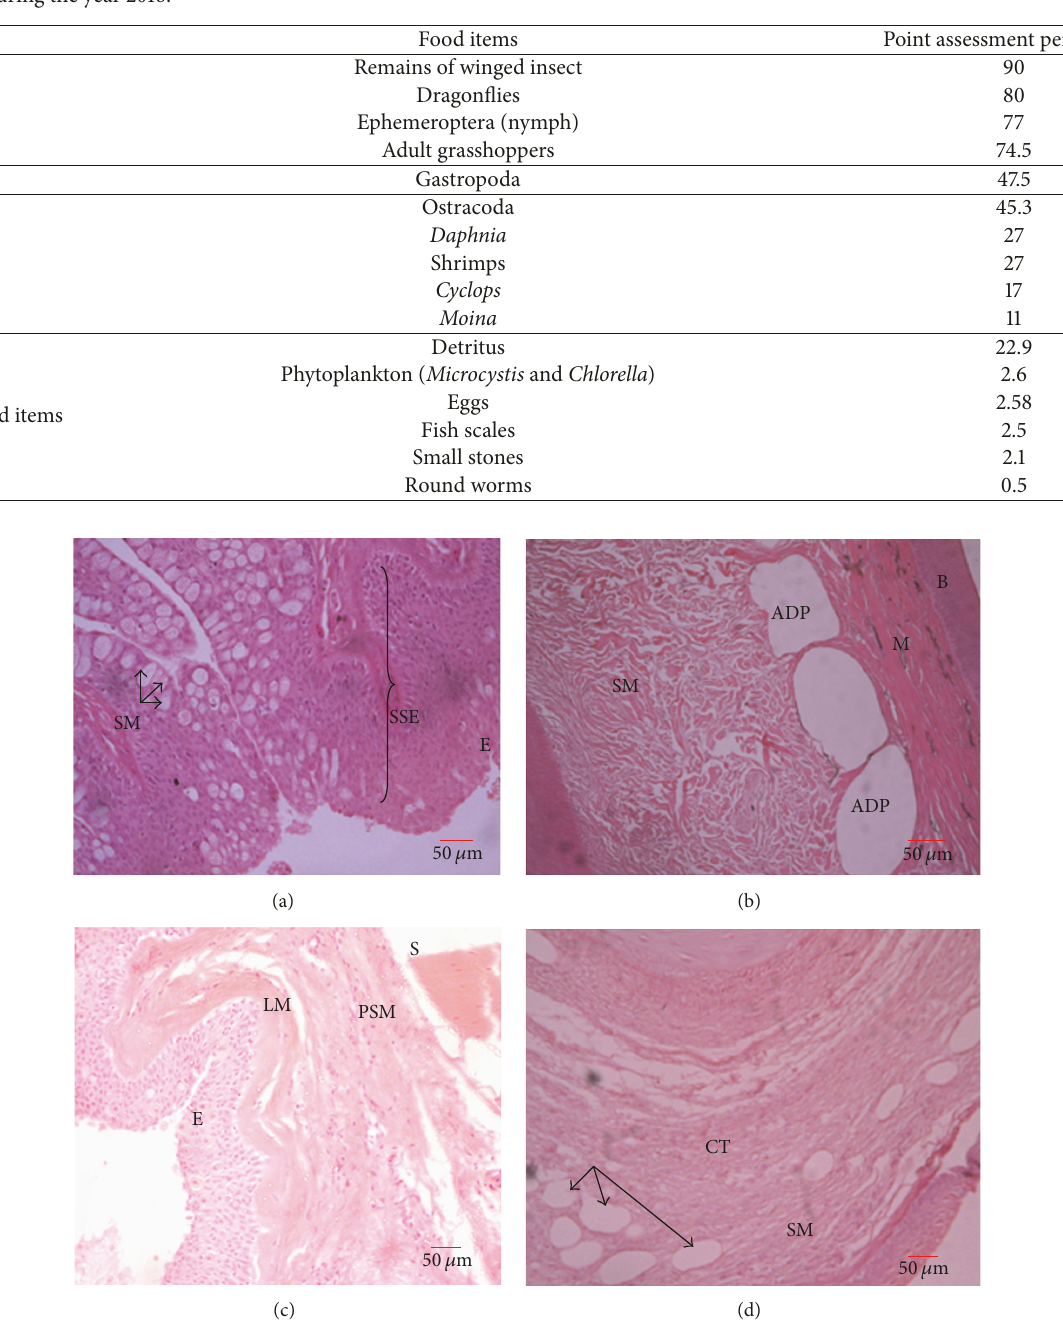
Table 2: Point assessment percentages of various categories of food items in the stomachs of Alestes baremoze collected from Lake Albert, Uganda, during the year 2016.